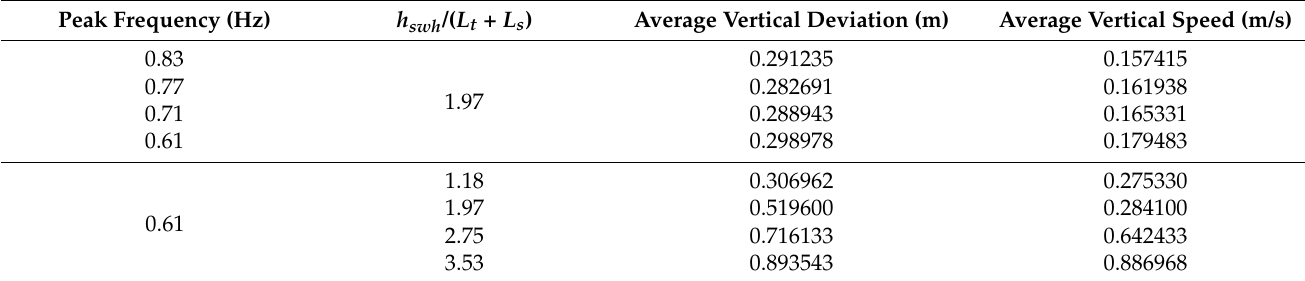
Figure 15. Floater vertical speeds resulted from a regular wave compared to random waves with different significant wave height-equal peak frequency ( left ) and to random waves with different peak frequency-equal significant wave height ( right ). Table 6. Average floater’s vertical deviation and vertical speed from different random waves.